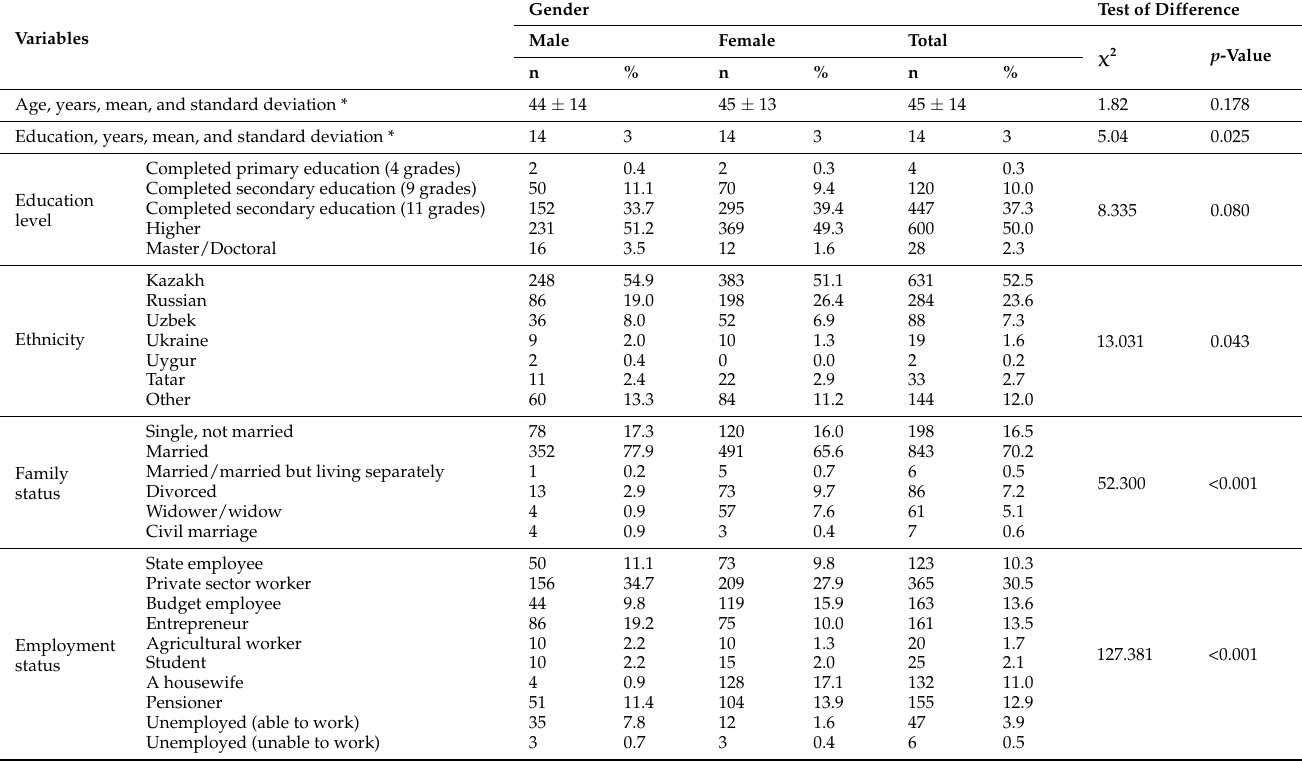
Table 1. General sociodemographic characteristics of study participants, n = 1201.